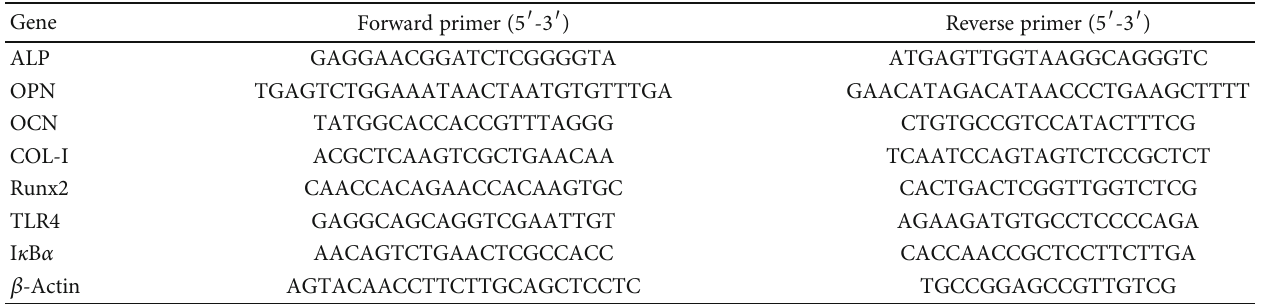
Table 1: Primer sequences for RT-PCR (supplied by Roche).